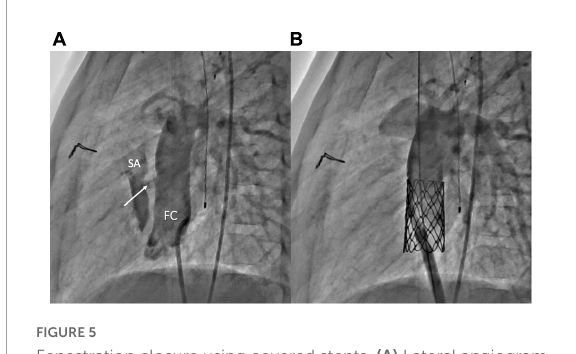
FIGURE5 Fenestration closure using covered stents. (A) Lateral angiogram of a Fontan conduit showing a fenestration (white arrow) between the conduit and the single atrium. (B) Lateral angiogram following fenestration closure using a covered CP stent (Numed) implantation within the conduit. FC, Fontan conduit; SA, single